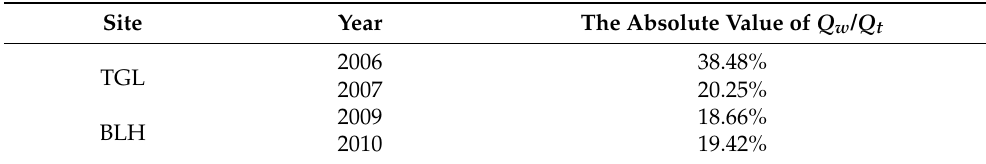
Figure 11. The effects of the energy due to temperature gradient ( Q t ) and that due to the phase change ( Q w ) upon the thawing depth ( TD ) of the active layer ( p < 0.05). Table 7. The relative contributions of the energy due to the temperature gradient ( Q t ) and that due to the phase change ( Q w ) towards the